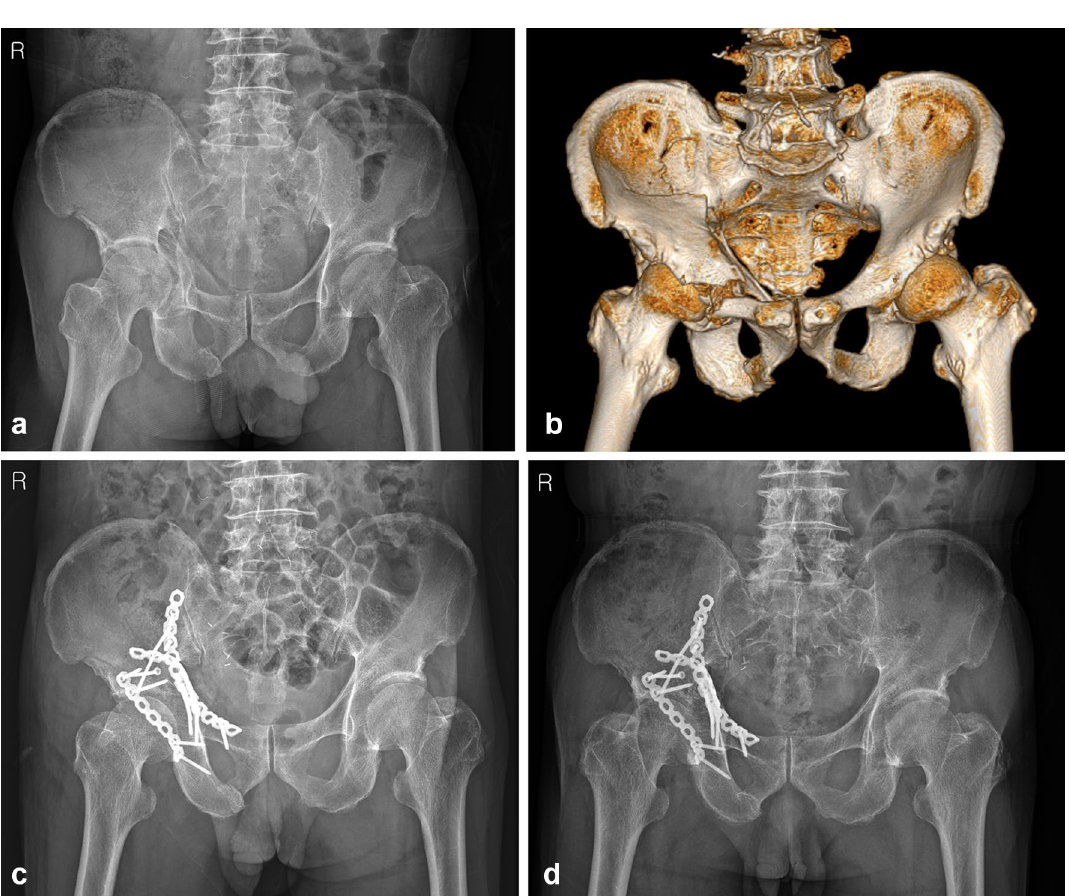
Figure 7. ( a ) pelvis anteroposterior radiograph and ( b ) 3D-CT of a 61-year-old male, superomedially displaced acetabular fracture with anterior wall fragment. ( c ) Immediate postoperative and ( d ) 77 months after surgery radiograph, after fixed with conventional reconstruction plate and additional buttress plate through modified ilioinguinal